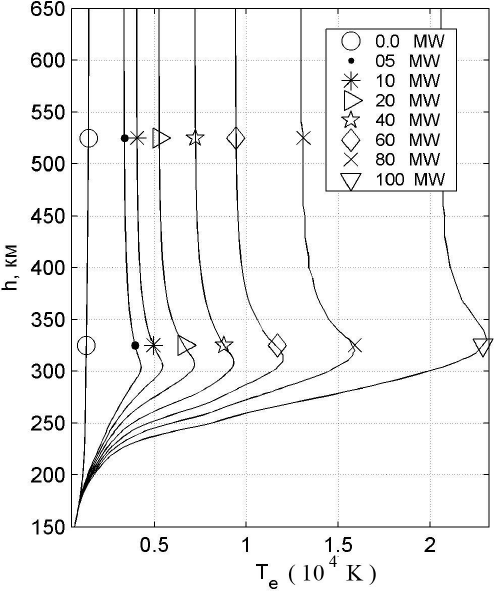
Fig. 2. Profiles of the electron concentration (in units of 10 5 cm − 3 ) versus distance from the Earth along the geomagnetic field line sit- uated in the illuminated region at the moment of 300s after turn on. The results are given for the same cases as in Fig.